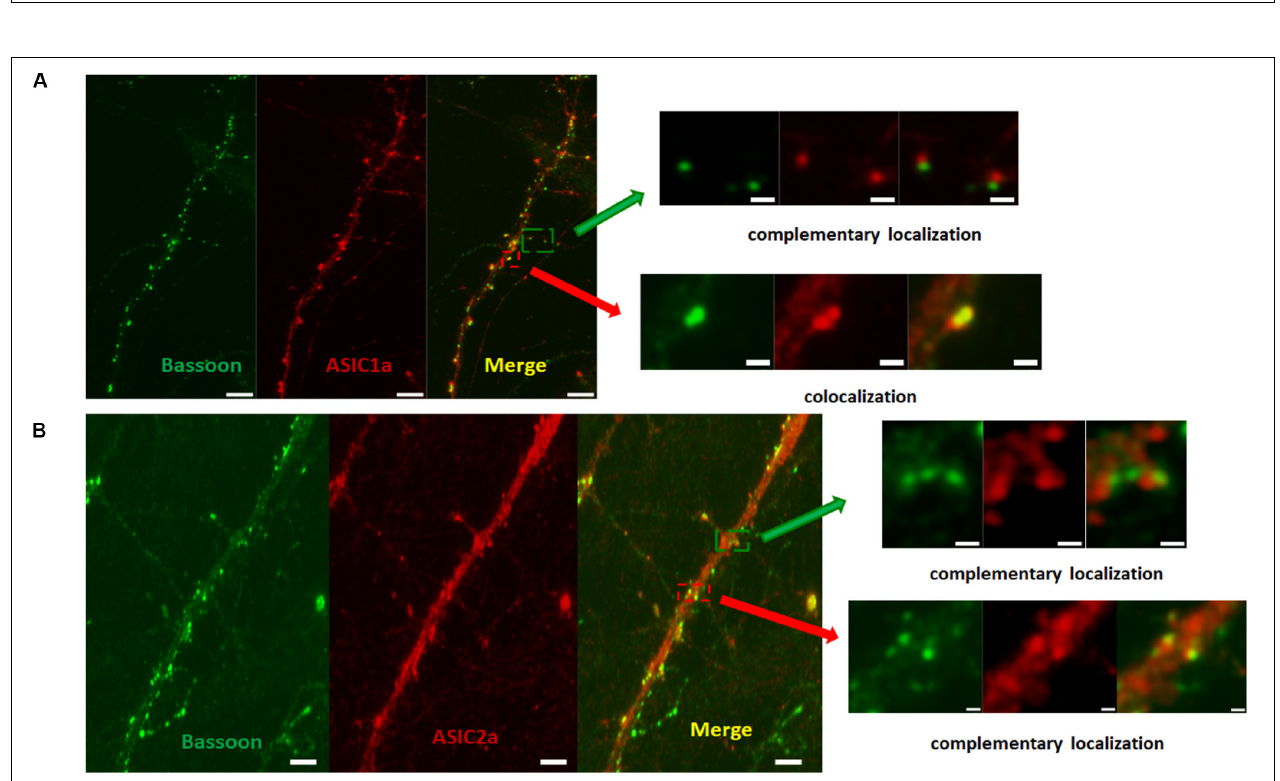
FIGURE 6 | ASICs is expressed on presynaptic membrane in mature hippocampal neurons. (A) Presynaptic localization of ASIC1a in DIV14 hippocampal neurons. Right row show magnifications as merged of rectangles in the overview images of the left row. The upper right shows complementary localization of ASIC1a (red) and Bassoon (green). The lower right shows colocalization of ASIC1a (red) and Bassoon (green). Scale bar was 6 µ m and 1 µ m for the left and right row, respectively. (B) Presynaptic localization of ASIC2a in DIV14 hippocampal neurons. Right row show magnifications as merged of rectangles in the overview images of the left row. The upper right shows complementary localization of ASIC2a (red) and Bassoon (green). The lower right shows colocalization of ASIC2a (red) and Bassoon (green). Scale bar was 4 µ m and 0.6 µ m for the left and right row, respectively.